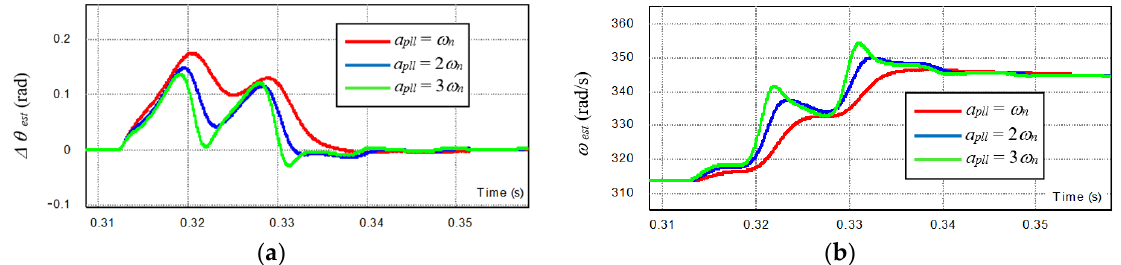
Figure 11. The estimated phase angle error ( a ) Δ θ est and estimated frequency ( b ) ω est for three different a pll values, for step input signal frequency variation.